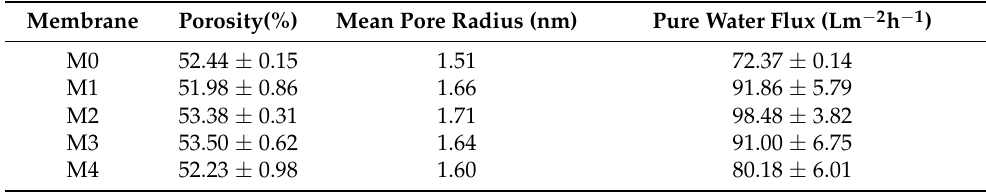
Figure 7. Water contact angle values ( a ) and the stress–strain behaviors ( b ) of PES and PES/MoS 2 membranes.